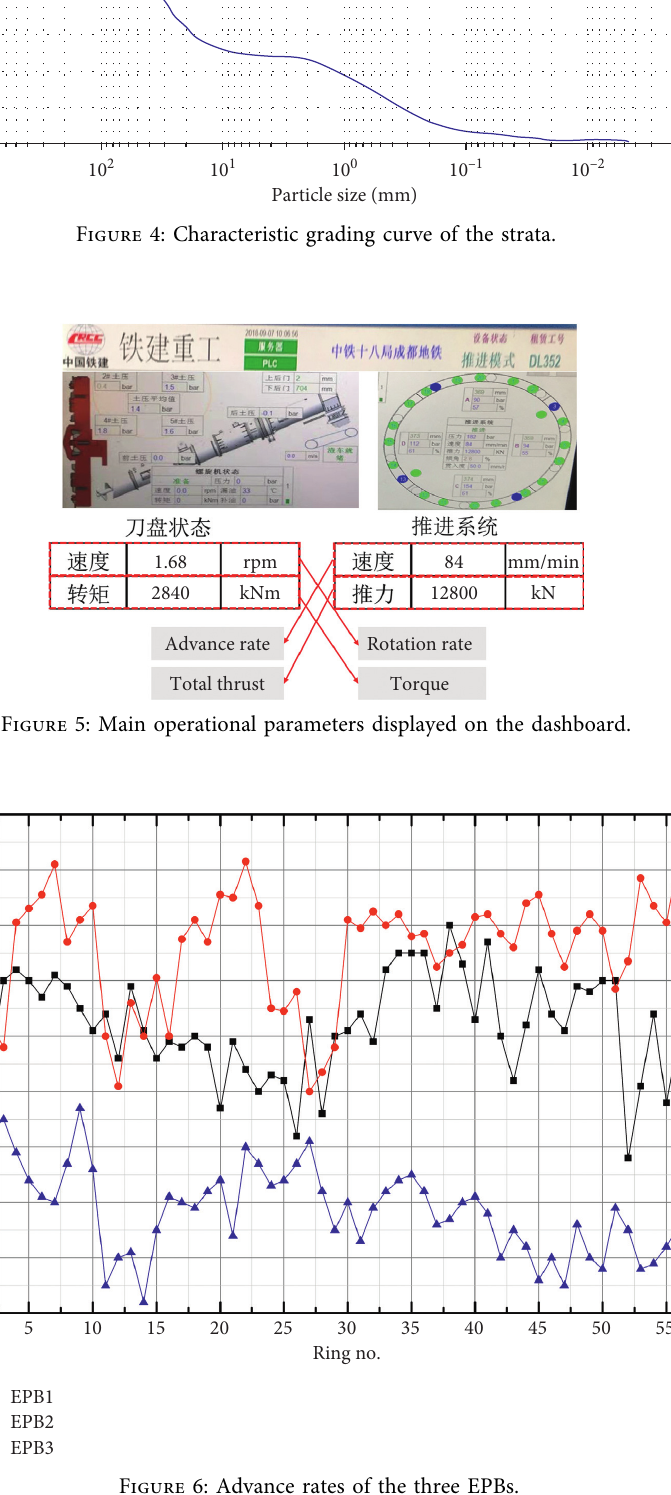
Figure 6: Advance rates of the three